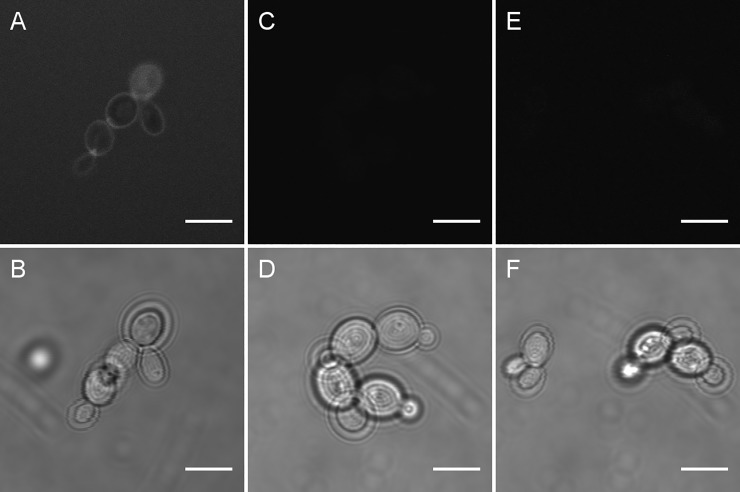
AMAC fluorescence (upper panel A, C, E) and transmission image (lower panel B, D, F) for C. guillermondii cells incubated for 24 hours with AMAC-C32 (A, B), unlabeled C32 (C,D) or without C32 (E,F). The concentration of C32 was equal to the minimal inhibitory concentration. The scale bar represents 5μm.